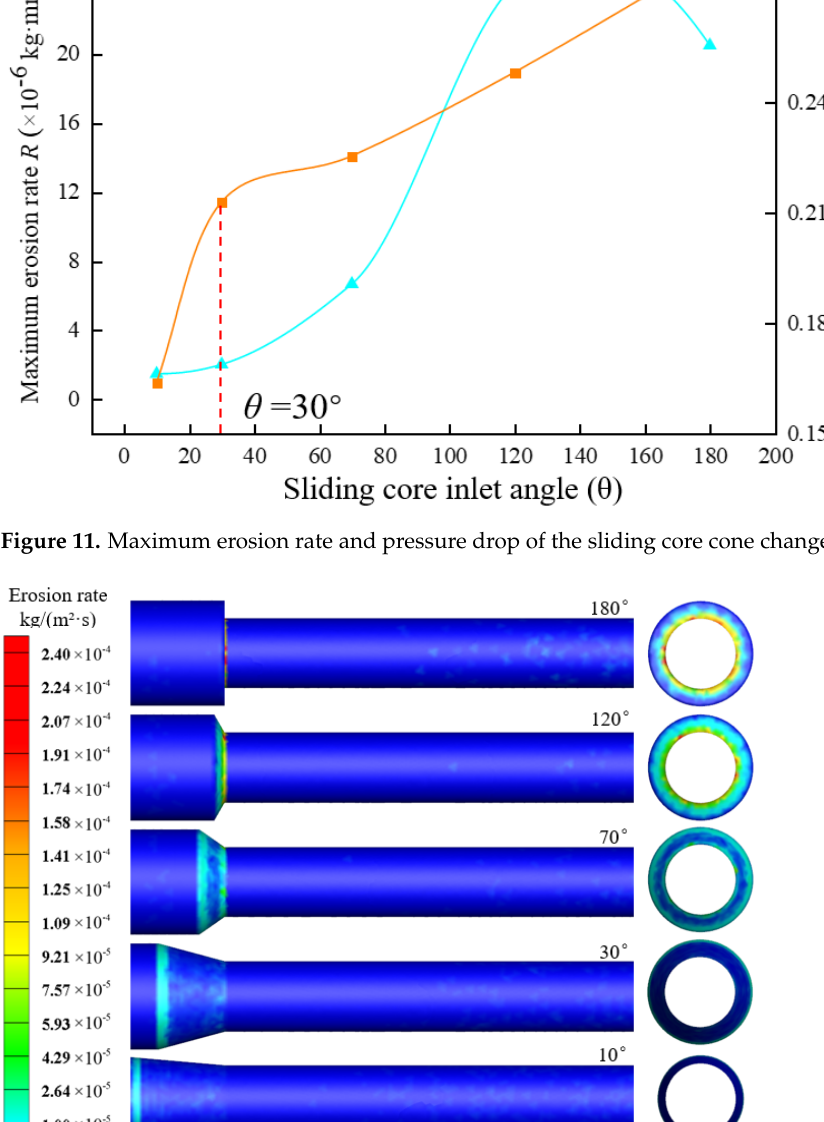
Figure 12. Erosion area changes with θ value.